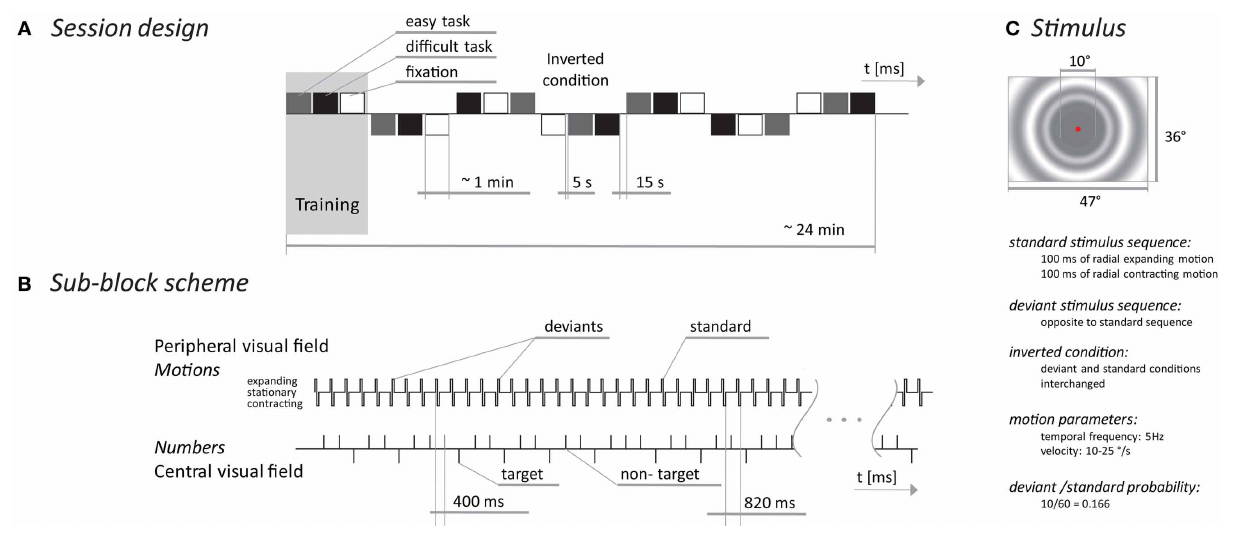
part of the visual field (upper time line) and events in the central part of the screen during the oddball task. The stimulus (C) depicts the spatial/temporal properties of the peripheral